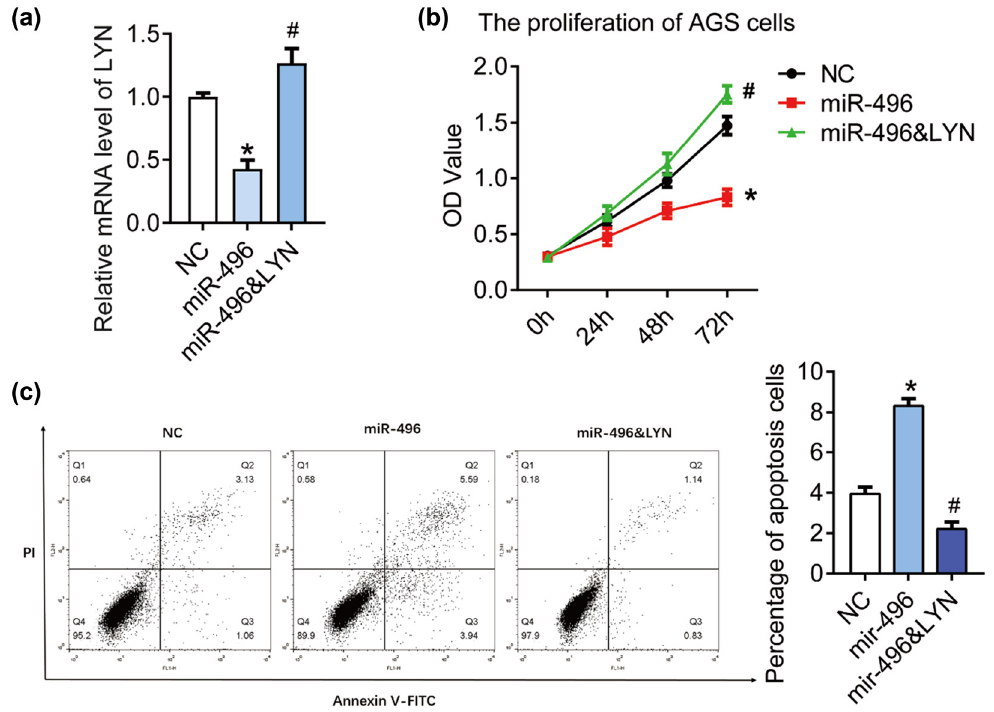
Figure 4: LYN blocked cell apoptosis induced by miR - 496 in gastric cancer cells. ( a ) QPCR was performed to detect the level of LYN in AGS cells transfected with miR - 496 mimics or miR - 496 mimics + LYN overexpression. ( b ) The proliferation was detected by CCK8 assay. OD value ( 450nm ) was measured every 24h. ( c ) Flow cytometry was performed to detect the apoptosis in AGS cells. NC = negative control. * P < 0.05; # P <